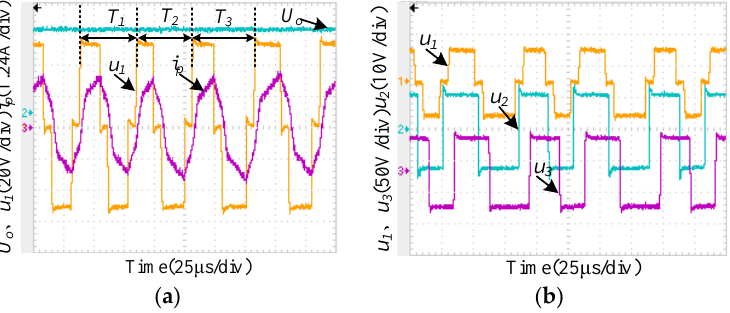
Figure 27. Measured waveforms of phase-shifted PWM control using discretely chaotic modulation: ( a ) converter voltage, current of port 1 and output voltage of port 2; ( b ) converter voltages of port 1, 2 and 3.